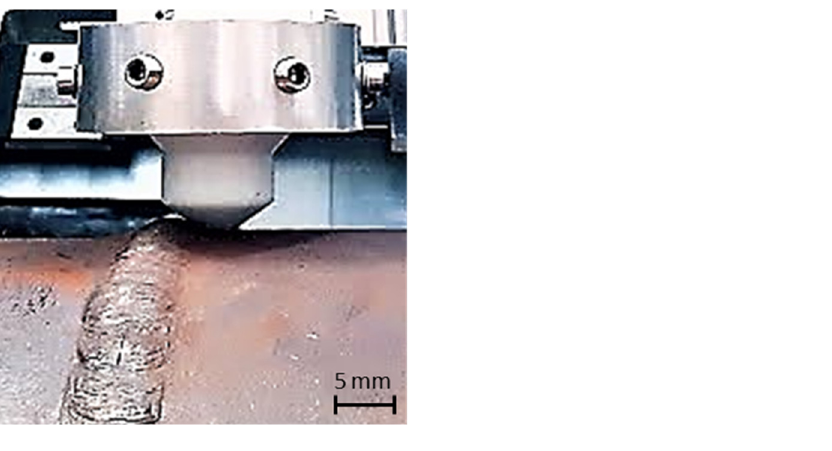
Figure 16. ECT probe developed for the weld bead inspection performing a scan on the bead’s right side.